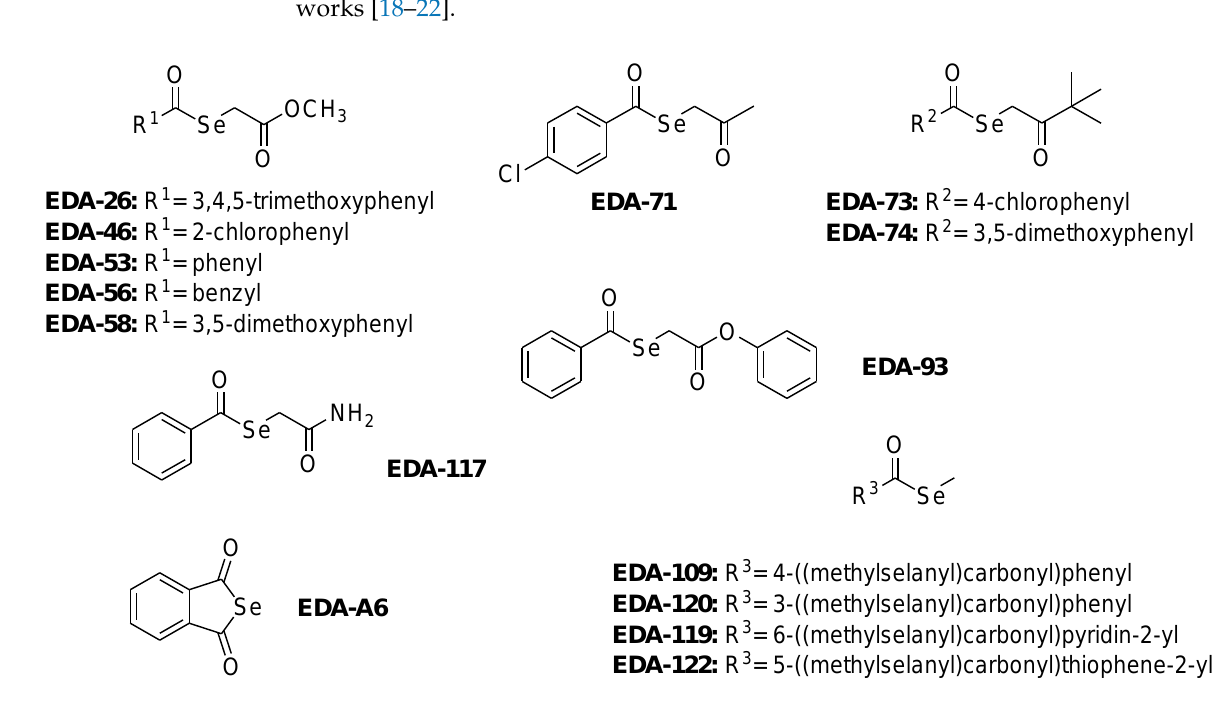
Figure 1. Tested selenocompounds with significant anticancer activity.